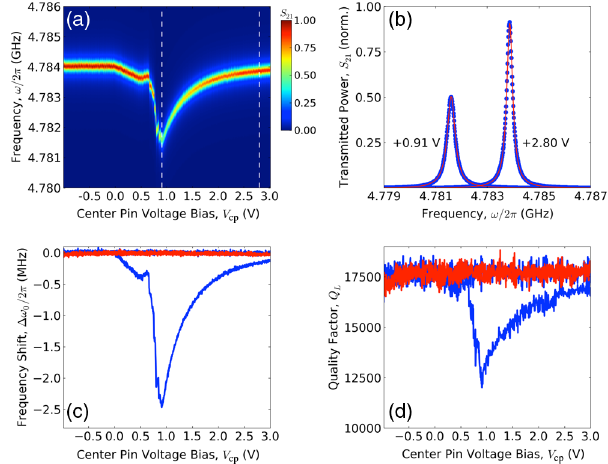
FIG. 3. Detection of a trapped electron ensemble on superfluid helium in a cavity transmission experiment. (a) Normalized transmitted power through the cavity as a function of center pin trap voltage V . (b) Normalized transmission spectra at cp ¼ þ 0 . 91 and þ 2 . 8 V, showing a shift in resonance fre- V cp quency and a reduction in transmitted power at the bias points indicated by the dashed vertical lines in (a). Solid red lines are fits to Lorentzians. (c) Resonance frequency and (d) loaded quality factor as functions of trap bias in the presence (blue) and absence (red) of an electron ensemble. In panels (a) – (d), electrons are first ¼ loaded into the cavity mode volume at an initial bias of V cp þ 3 V and a fixed helium level in the capillary regime with an uncharged shift of Δ ω 0 = 2 π ¼ − 7 . 58 MHz and a reservoir level of H ≃ 4 mm. The blue line shows the trap voltage being swept from þ 3 to − 1 V and back in 4 mV steps, eventually depleting the trap region, while the red line shows the same sweep for an empty